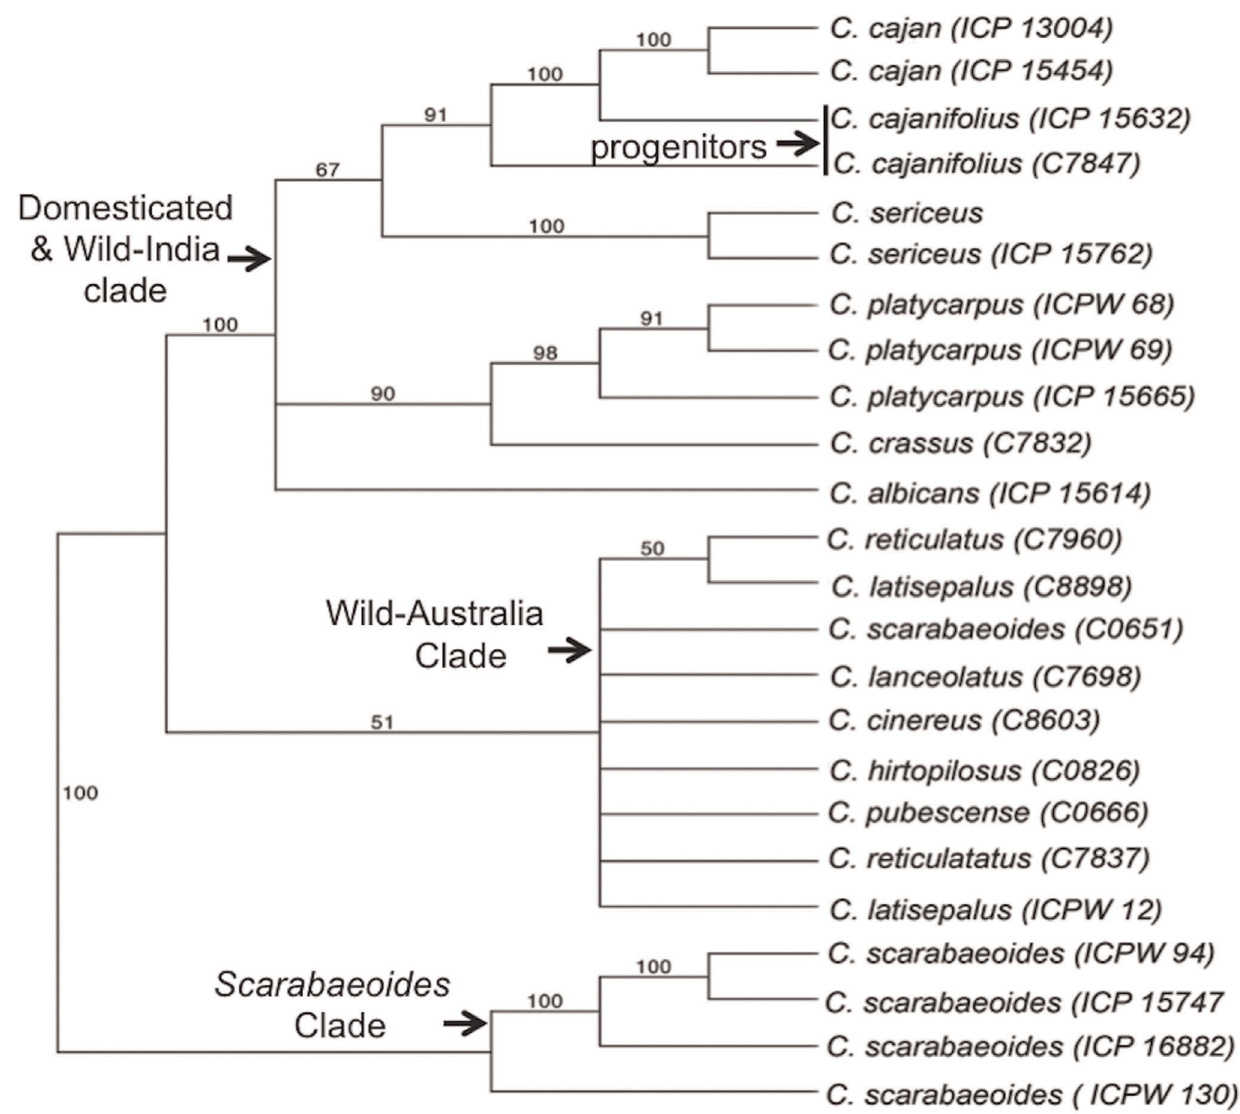
Figure 2. Phylogeny of Cajanus species depicted as a 50% majority rule consensus tree. Tree topology was inferred with maximum parsimony via heuristic searches among 1000 trees. Numbers above branches indicate bootstrap support ( . 50%). The vertical bar indicates the putative projentitor species (two C. Cajanifolius accessions). Tree length =2145, consistency index (CI) =0.638, and retention index (RI) =0.837. The Bootstrap support for the sister relationship between wild-Australia and Wild-India clades (in the absence of the two C. cajan accessions) is 100% (data not shown).